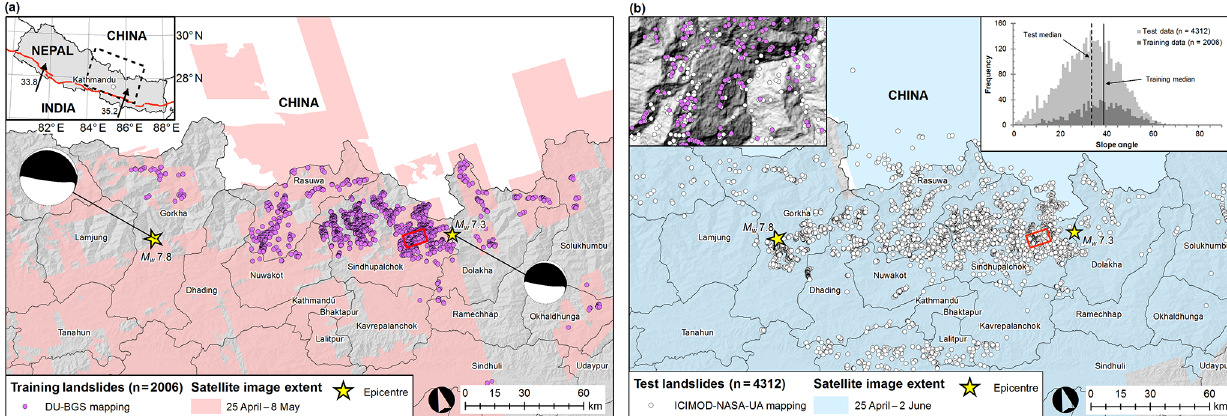
Figure 1. Training and test landslide inventories from different mapping efforts following the 2015 Gorkha earthquake. (a) Training land- slides identified by the joint DU–BGS group using satellite imagery available for 7 May 2015. Inset: study area location within Nepal showing main plate boundary in red and relative plate motion vectors in mmyear − 1 from Bettinelli et al. (2006). Focal mechanisms are taken from the Global CMT catalog; (b) test landslides identified by the joint ICIMOD–NASA–UA group using satellite imagery available for 2 June 2015. Inset: direct comparison between locations of training and test landslides. Graph shows the frequency of landslides in the training and test datasets compared to slope angle: training landslides occur on median slope angle of 40 ◦ ; test landslides occur on median slope angle of 34 ◦ .